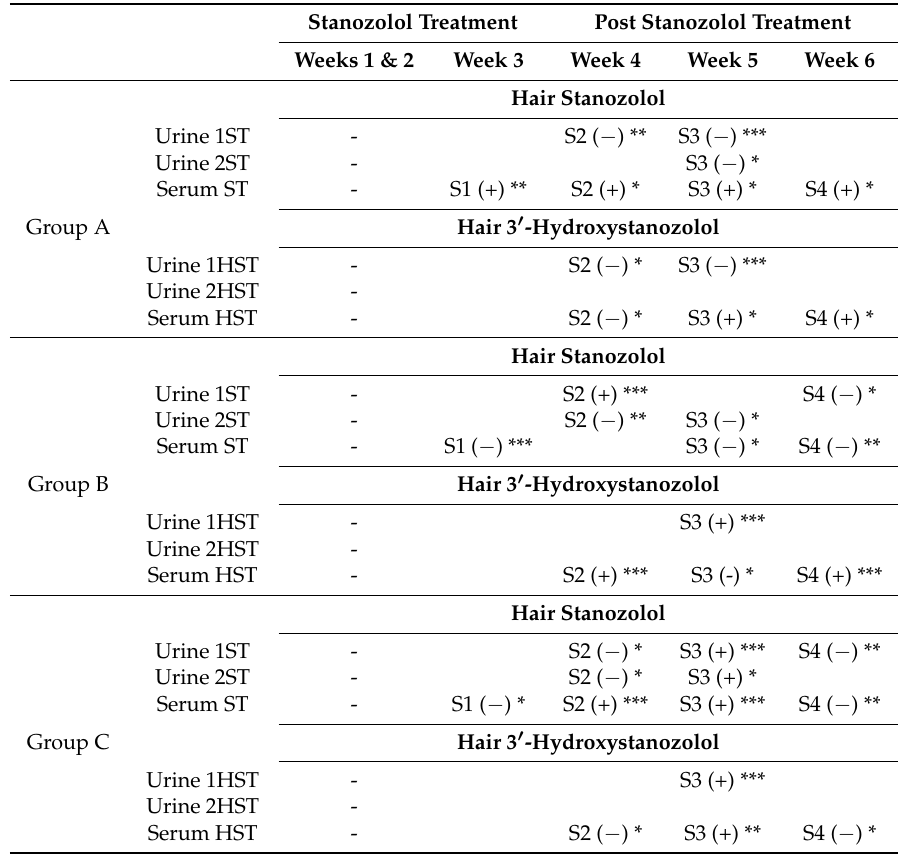
Table 1. Relationship between levels of stanozolol and 3 (cid:48) -hydroxystanozolol in hair and in urine and blood samples for the closest corresponding time period (2